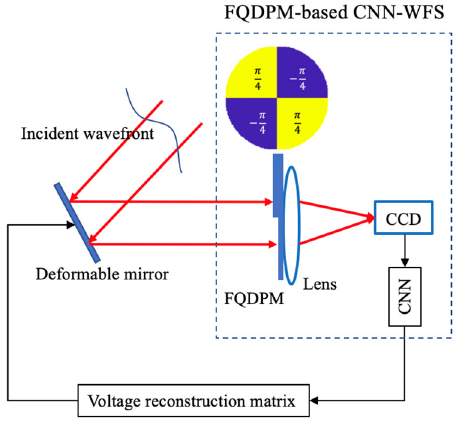
Figure 1. Schematic diagram of the four-quadrant discrete phase modulation (FQDPM)-based convolutional neural network adaptive optics (CNN-AO) system.